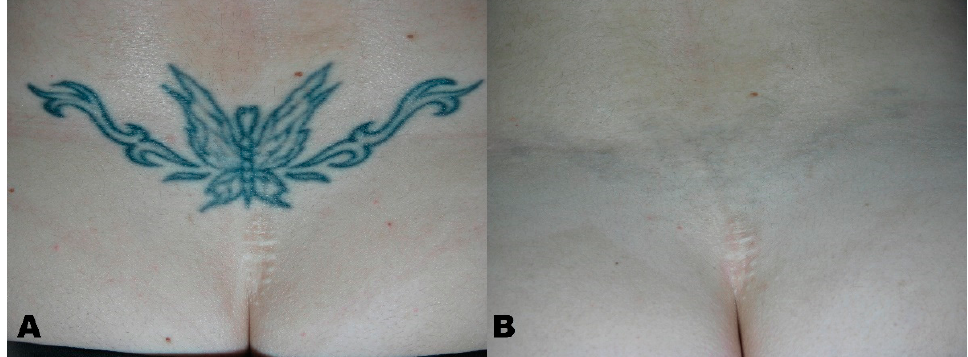
Figure 1. ( A ) Picture before starting tattoo removal treatment, and ( B ) the same region at the 6-month follow-up, after all tattoo removal sessions had been completed.